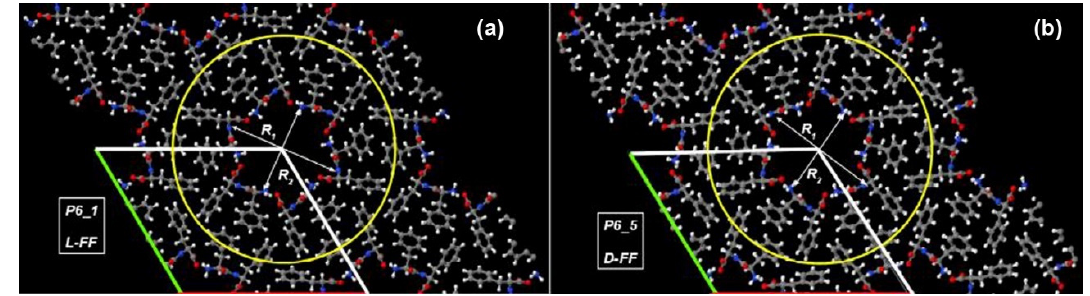
Figure 1. Images of molecular crystals composed of: ( a ) L-FF PNTs (space group P6 1 ), and ( b ) D-FF PNTs (space group P6 5 ). Hexagonal unit cells are marked with green, red, and white lines. The individual PNTs in crystal are highlighted by yellow circles. Atom colors: oxygen—red, nitrogen—blue, carbon—grey, and hydrogen—white.